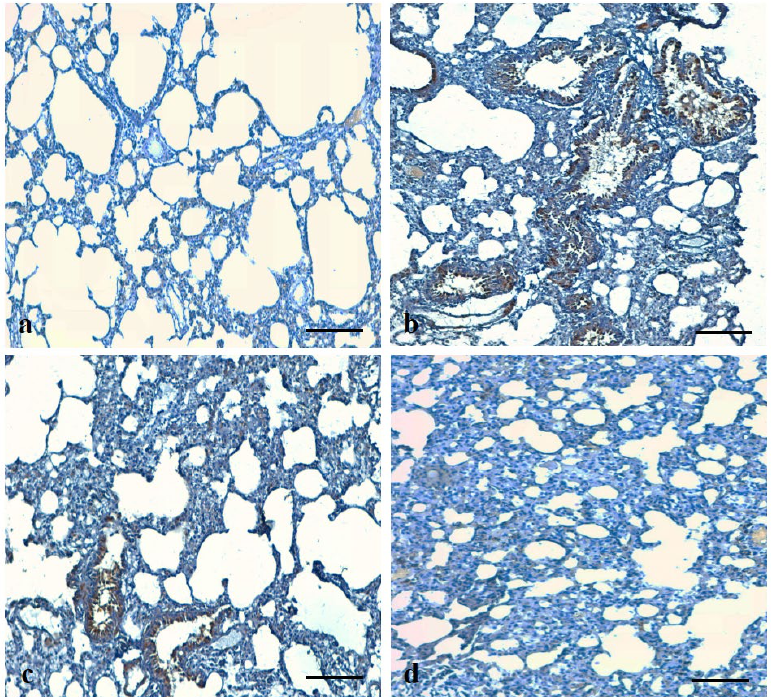
Figure 11. Expression pattern of VEGF was evaluated. ( a ) In the control group, there was no expression of VEGF protein; ( b ) in the B(a)P-only-treated group, VEGF protein expression was high ( c ) in the ADE + B(a)P treatment group, the expression of VEGF protein was decreased ( d ) in ADE-treated group only, VEGF protein did not show any expression (Scale bar = 100 µ m). 3.11. ADE attenuates B(a)P-Induced Apoptosis in Lung